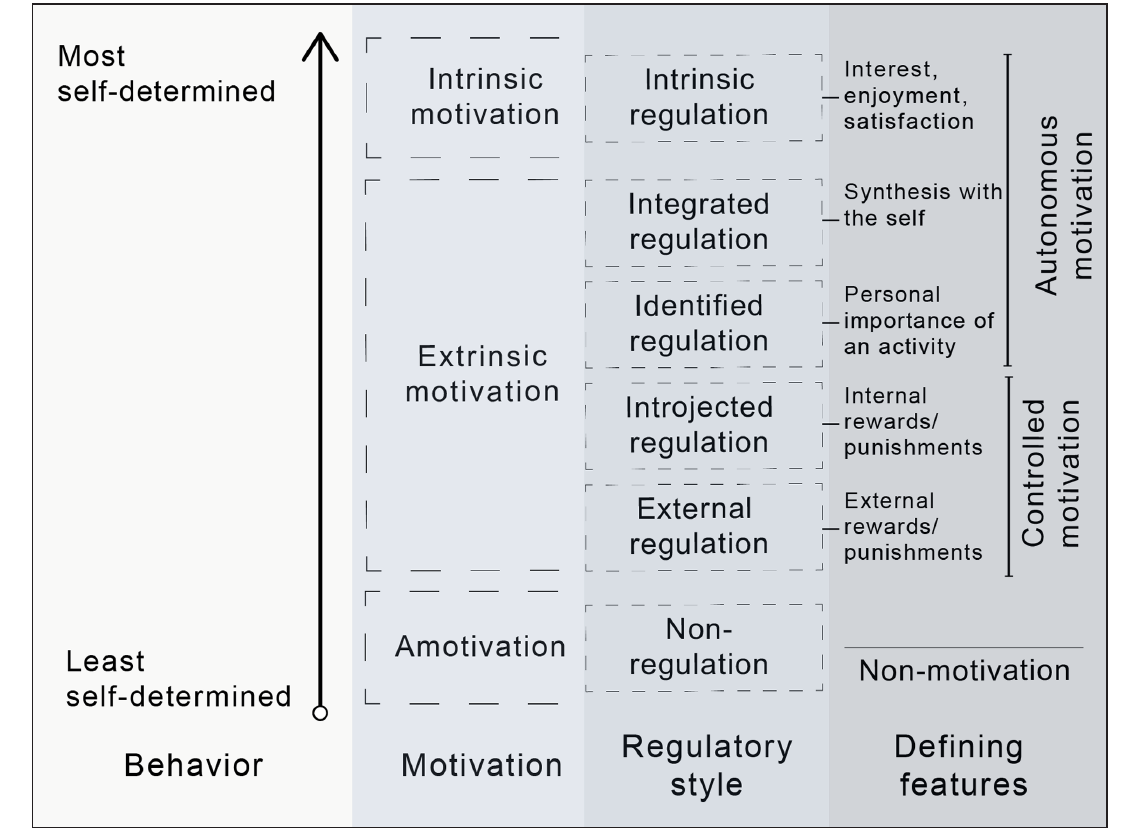
Figure 2: The spectrum of motivation according to the Self-Determination Theory (adapted from Ryan and Deci 2000b). Table 3: Motivations defined by Ryan and Deci (2000a) with examples extracted from the